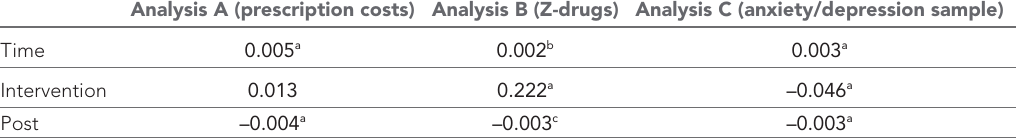
Table 6 Secondary analysis regression